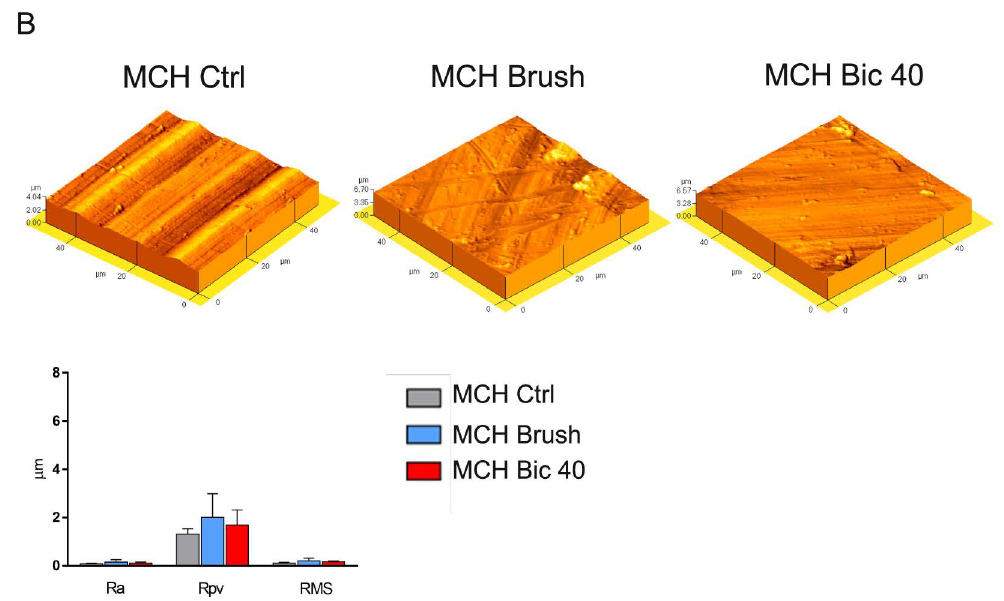
Figure 1. Machined (MCH) surfaces characterization after cleaning treatments. ( A ) Scanning electron microscopy (SEM) analysis at di ff erent magnifications was carried out on MCH titanium surfaces from the three experimental groups (Ctrl, Brush and Bic40, as indicated) in order to evaluate the surface topography. Scale bars: 100 µ m (left) and 20 µ m (magnifications on the right). ( B ) Atomic force microscopy (AFM) analysis of MCH surfaces. Histograms report the surface roughness expressed as Ra, Rpv and Rsm values. Values represent mean ± SD of three independent experiments; one-way ANOVA followed by Newman-Keuls post-hoc